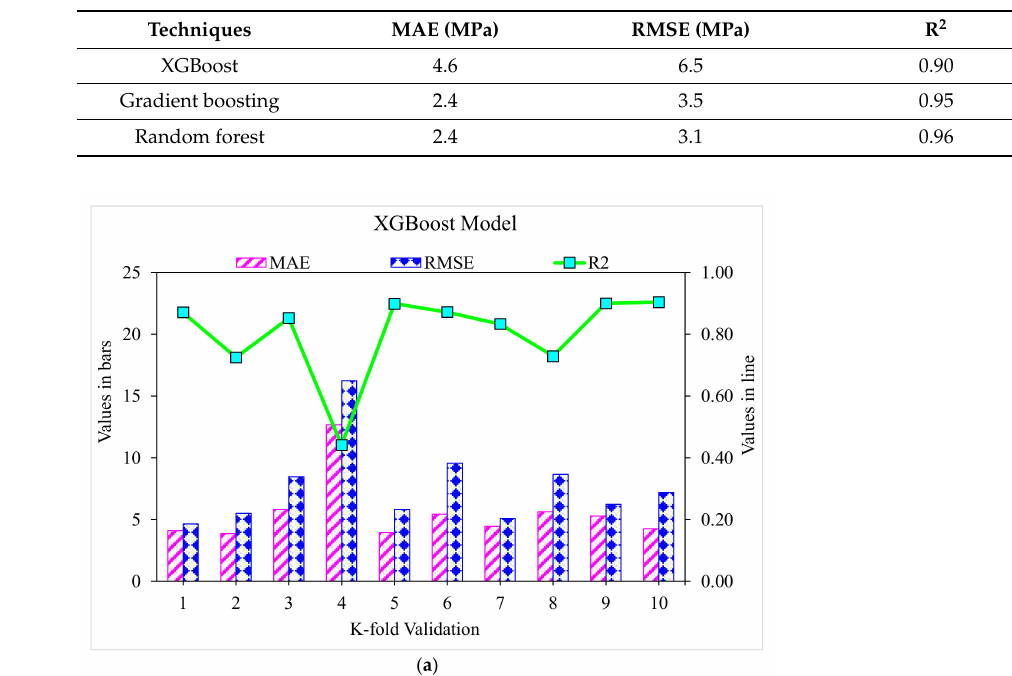
Table 1. Statistical checks of XGBoost, gradient-boosting, and random forest models.